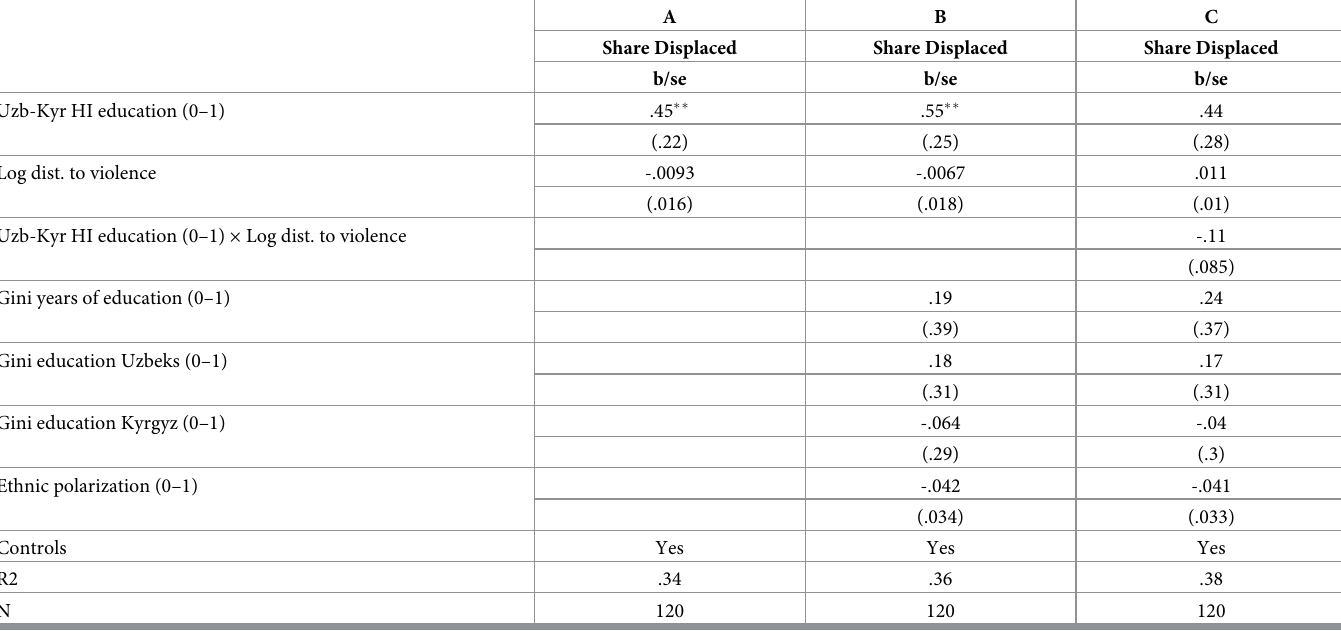
Table 4. Displacement in communities and